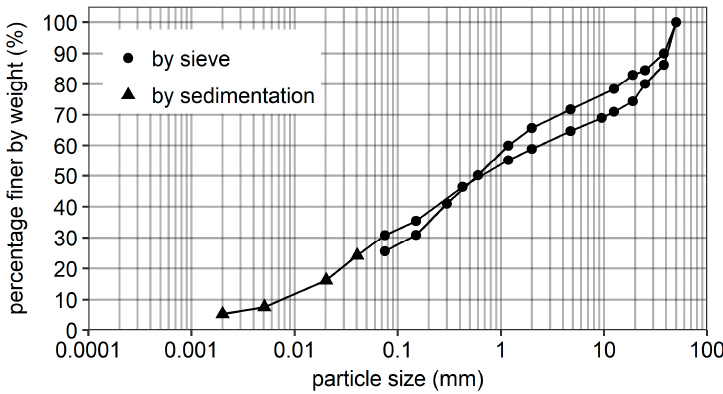
Figure 5. Particle-size distribution of the material used for the construction of the monitored embankment.